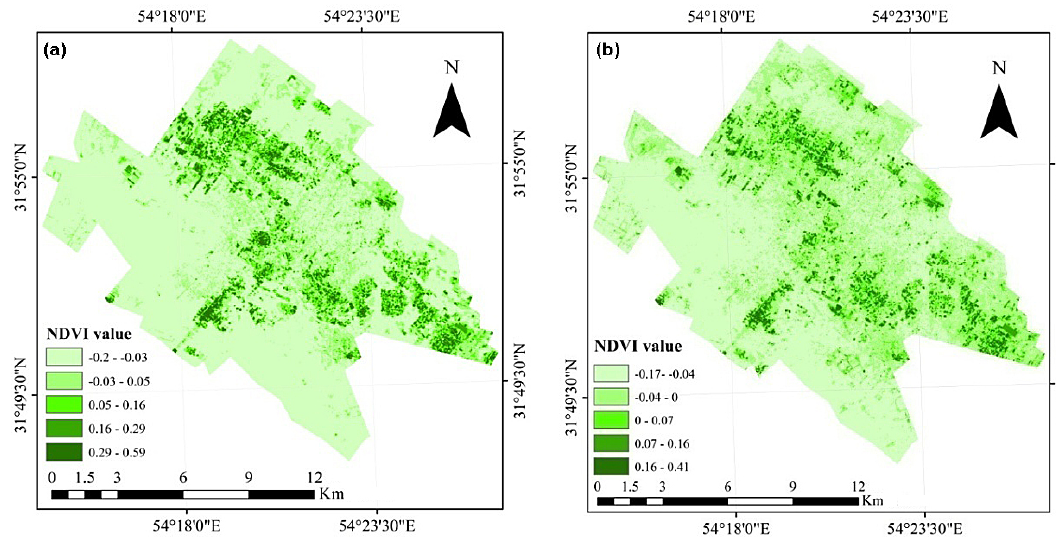
Figure 7. Spatial distribution of NDVI obtained from Landsat TM data: (a) 8 August 1998, (b) 6 August 2009.